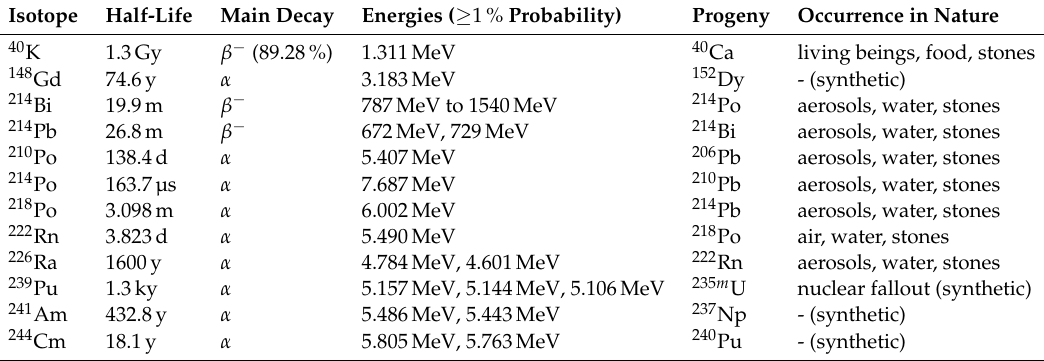
Table 1. Properties of measured isotopes, mostly from naturally occurring radioactive materials (NORM). From the 238 U decay chain only the relevant short-lived isotopes are included. For β − -decays, the maximum energy of each continuous spectrum is stated. The 232 Th decay chain is omitted since the half-life of its radon progeny 220 Rn is orders of magnitude lower compared to 222 Rn and, therefore, less relevant in our measurements. The progeny of the 232 Th series has in general similar characteristic decay energies in comparison to the 238 U